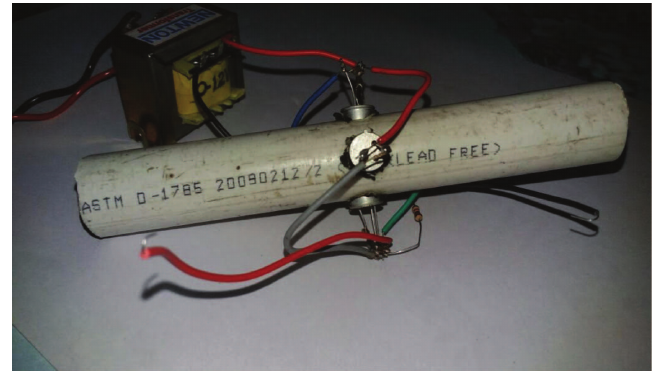
Figure 1: Semiconductor-based Anemometer.